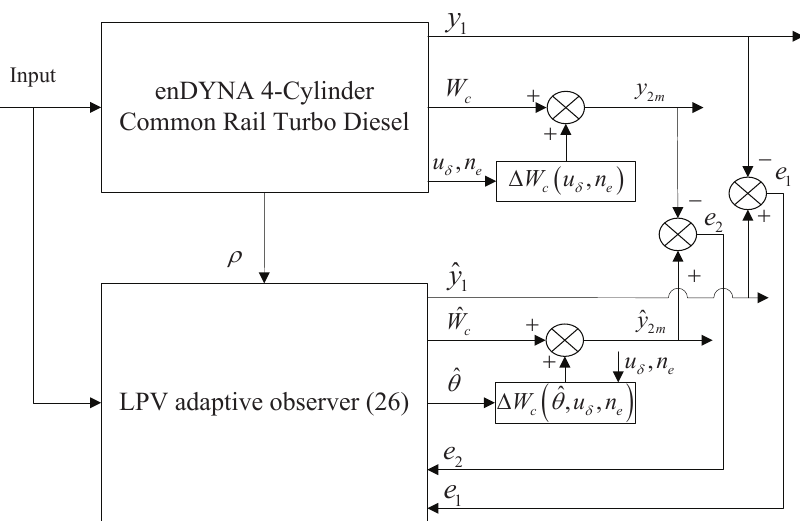
Figure 2. Schematic diagram of the adaptive observer.